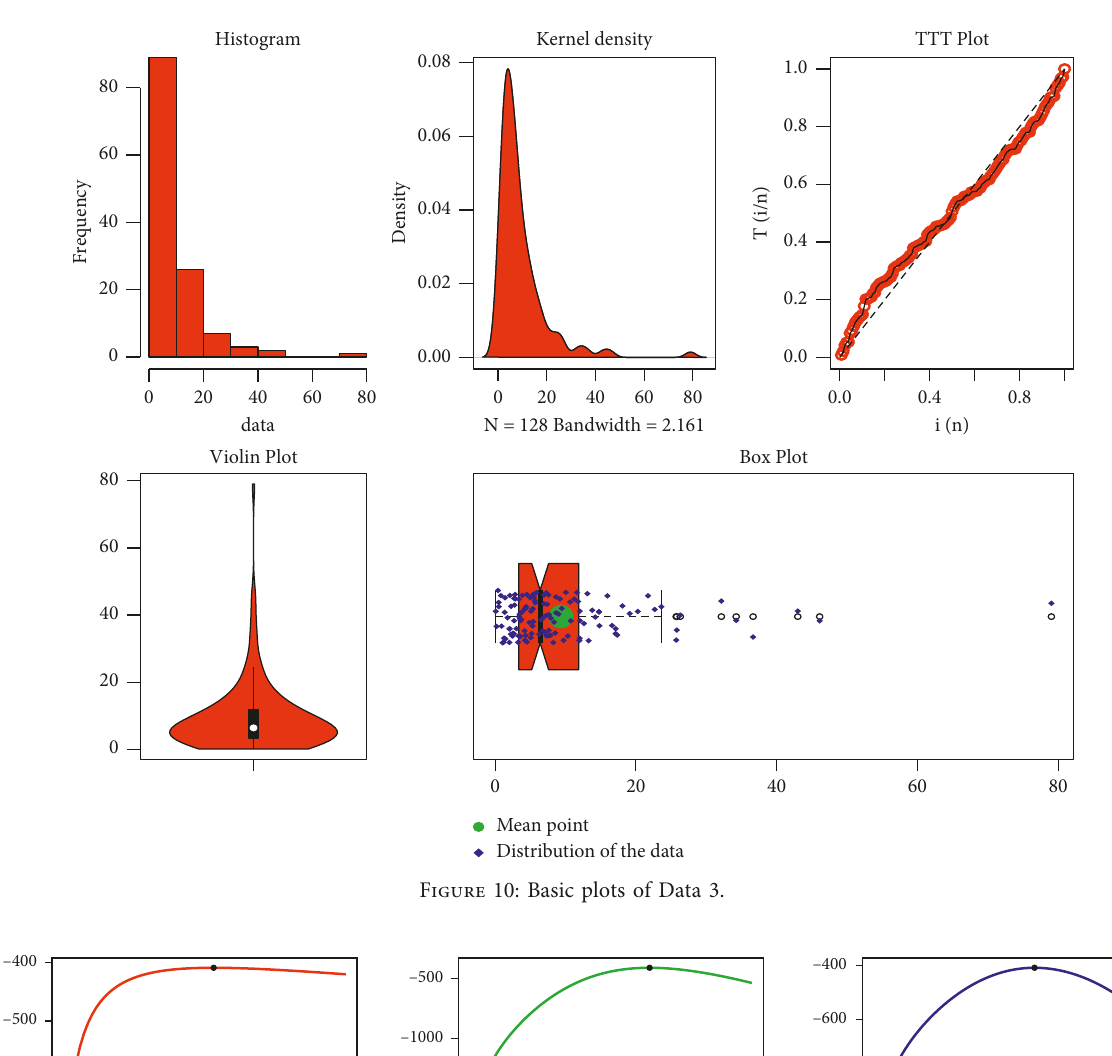
Figure 10: Basic plots of Data 3.